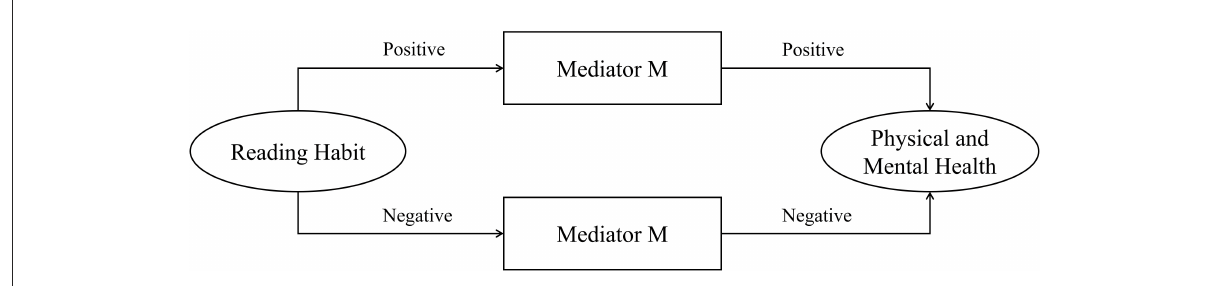
FIGURE2 Positive conduction path schema of mediator variable M.